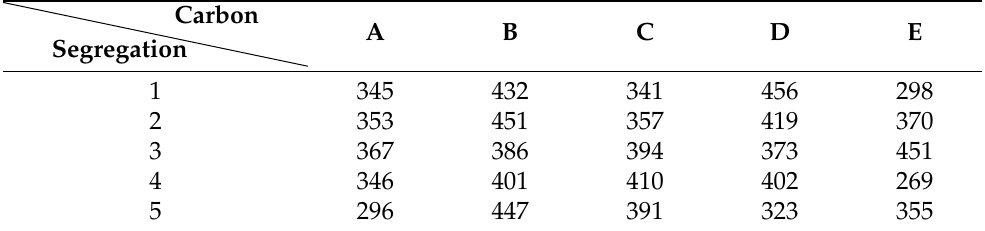
Table 2. The data distribution of dataset Single-Phase Metallographic Image Dataset (SPMID) based on carbon level and segregation degree.